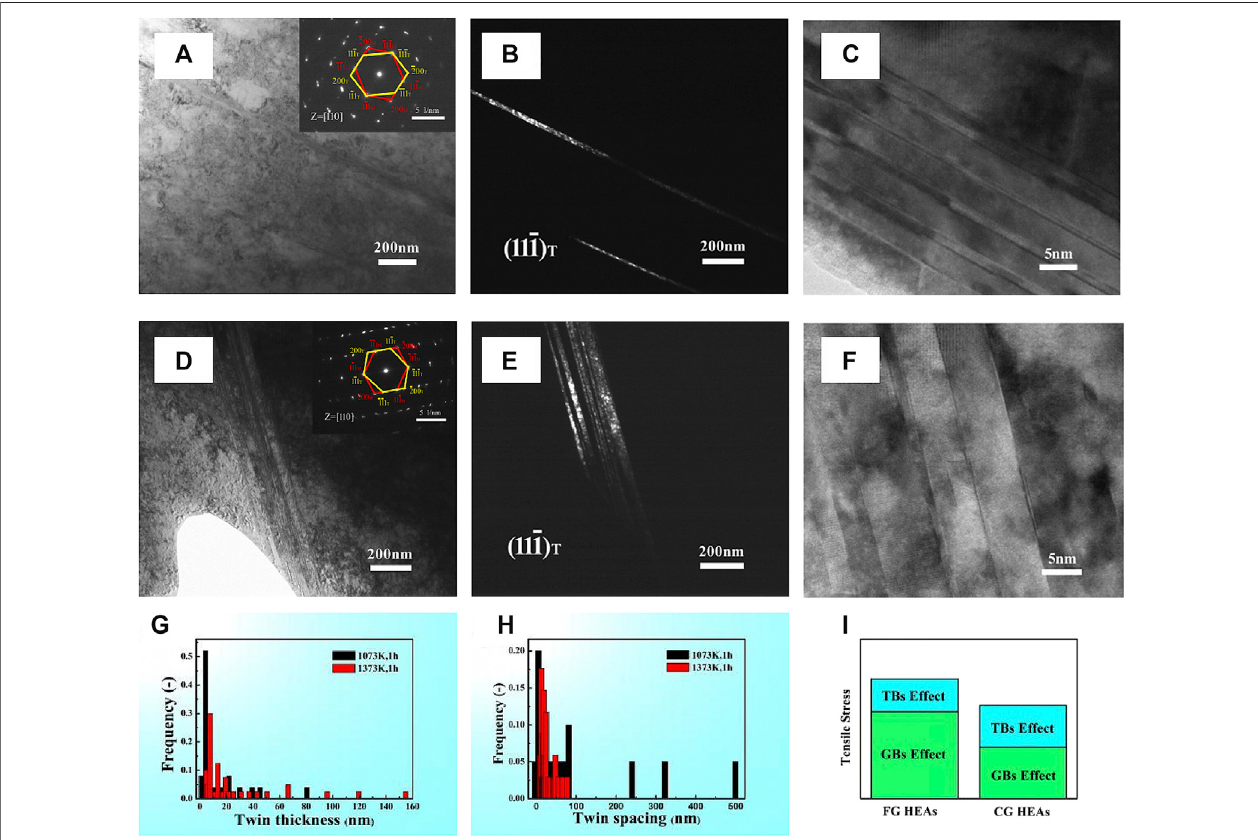
FIGURE7|(A) Bright- fi eld(BF)imagewithcorrespondingselected-areadiffractionpattern(SADP), (B) dark- fi eld(DF)image,and (C) high-resolutionTEM(HRTEM) image of FG ( ∼ 4.7 μ m) HEA, (D) BF image with corresponding SADP, (E) DF image, and (F) HRTEM image of CG ( ∼ 59.5 μ m) HEA; statistics of twin thickness (G) , and twin spacing (H) , (I) schematic illustrations of the contribution of twin boundaries (TBs) and grain boundaries (GBs) to the tensile stress of FG and CG HEAs (Yang et al., 2019c). (Reprinted from Journal of Alloys and Compounds, Vol 795, Yang et al., Revealing the Hall-Petch relationship of Al0.1CoCrFeNi high-entropy alloy and its deformation mechanisms, Pages No.272, Copyright (2019), with permission from Elsevier).